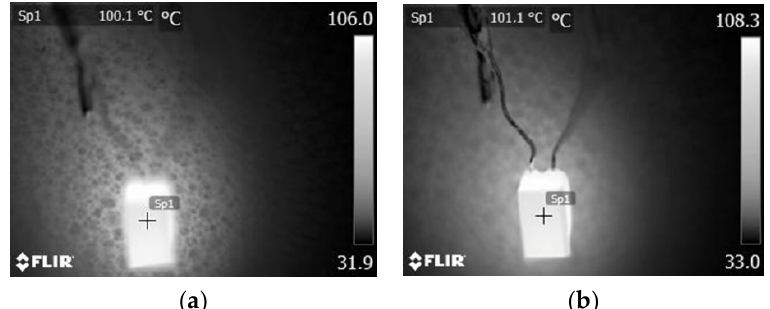
Figure 12. Thermograms made to confirm the proposed method: ( a ) thermogram classified by the perceptron as sharp ( ϑ m = 100.1 ◦ C, ϑ p = 101.5 ◦ C), ( b ) thermogram classified by the perceptron as out of focus ( ϑ m = 101.1 ◦ C, ϑ p = 101.5 ◦ C).